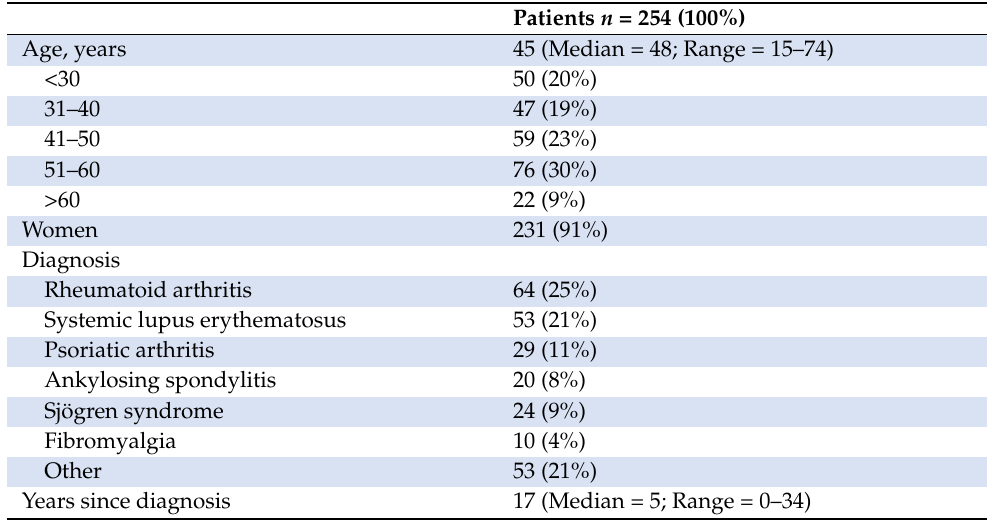
Table 1. Patient characteristics (mean or n (%)).